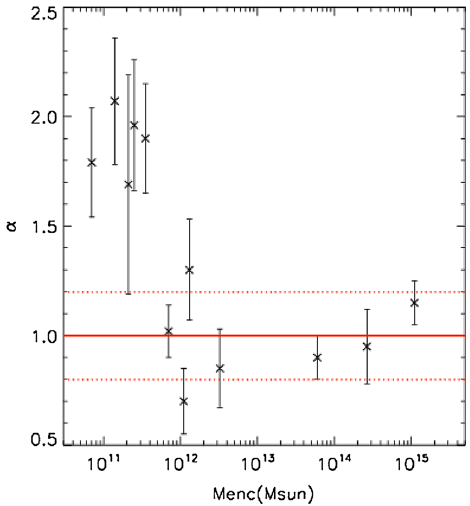
Fig. 39 The central log-slope α of the density distribution ρ ∝ r α for 9 galaxies/groups and 3 lensing clusters as a function of the enclosed lensing mass. Marked in red is the prediction from structure formation simulations of the standard cosmological